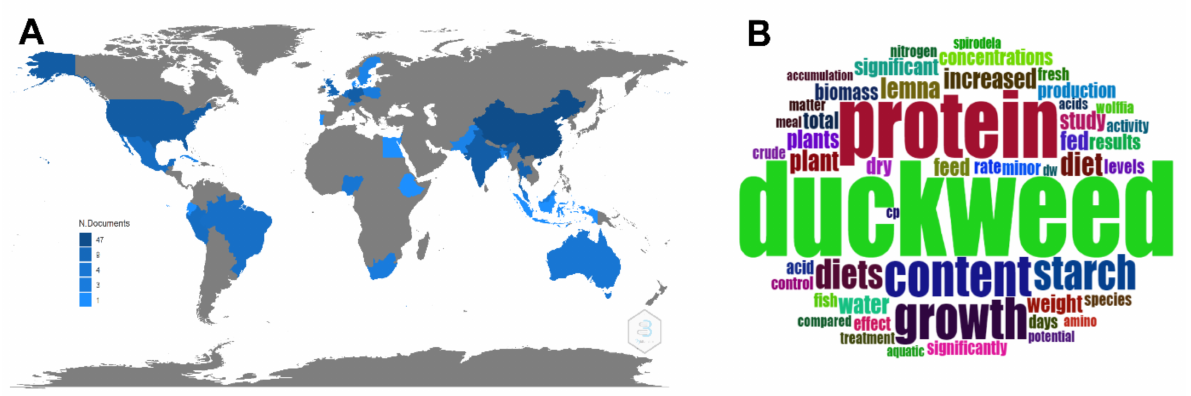
Figure 1. Bibliometric analysis of the occurrence and keyword distribution in the world’s research contributed to publications about duckweeds feedstocks. ( A ) Worldwide distribution network of publications among countries that have published papers related to nutritional feed-in duckweed species. The color intensity of the countries represents the number of articles found. ( B ) The panel of keywords that occur more often in recovered work from the bibliometric analysis. The larger the word size, the greater the word’s frequency in these studies ( n = 80). Data extracted from 80 articles found in the Scopus database with the search described in Box 1. Accessed: 31 August